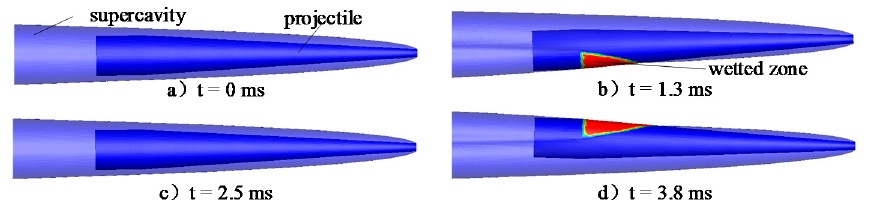
Figure 8. Relative position between supercavitating projectile and supercavity at the initial stage.